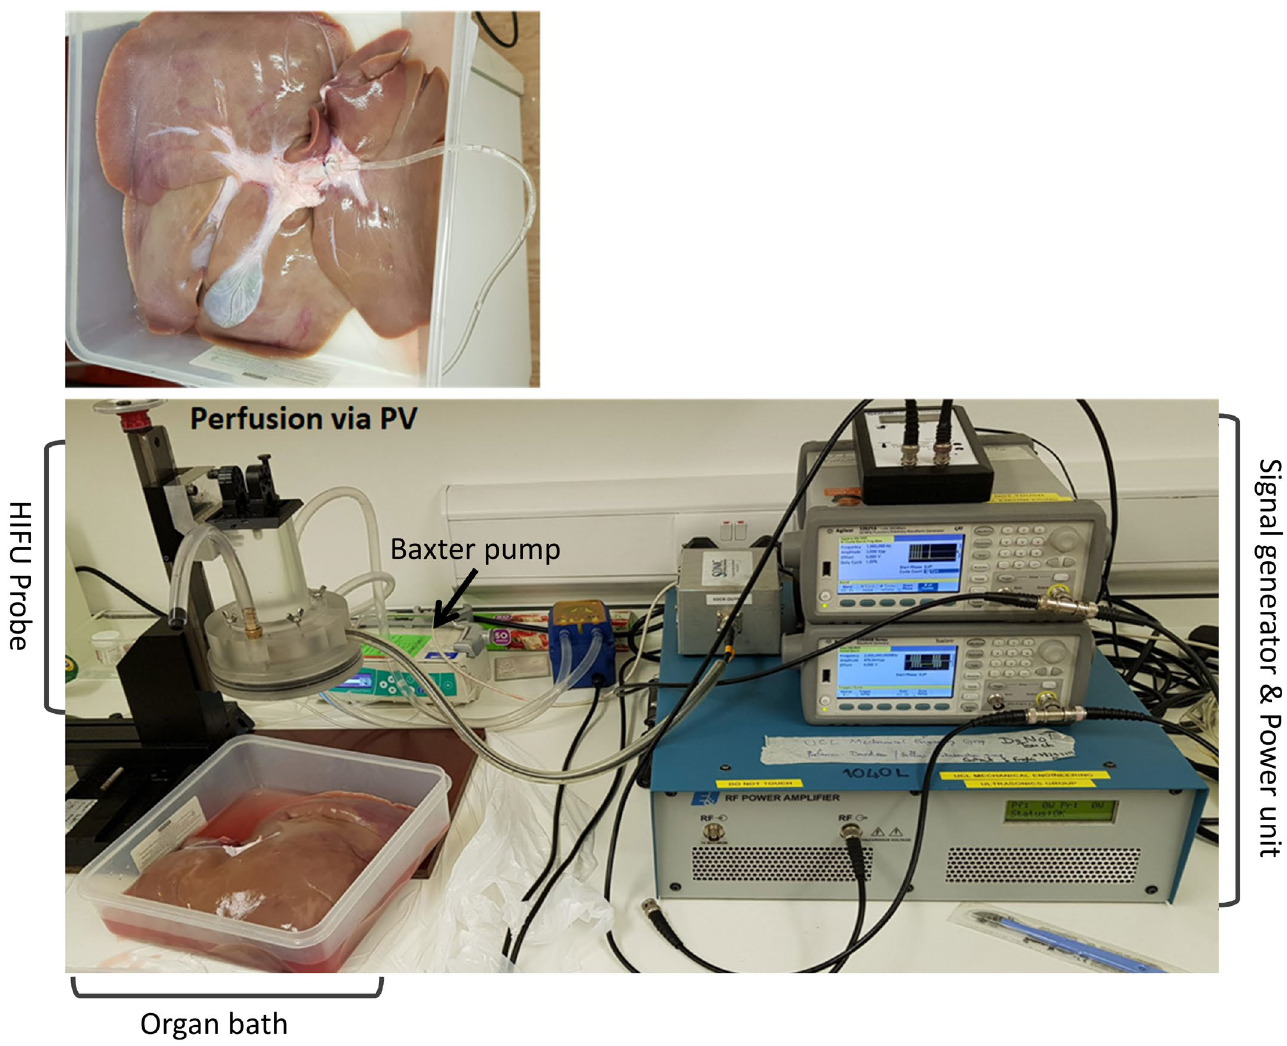
Figure 2. Experimental set up for HIFU probe and histotripsy protocol. Retrieved pig liver is placed in an organ bath and cannulated via portal vein for perfusion with Soltran solution with a Baxter pump. The perfusate is collected in the organ bath, which is then drained out of bath to ensure the probe is not submerged under accumulating perfusate fluid. The perfused liver is placed under the HIFU probe. The signal generator and power unit are adjusted to a set parameter for this experiment.